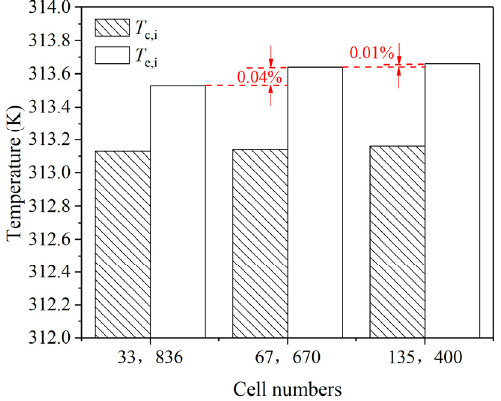
Figure 5. Comparison with different mesh size.